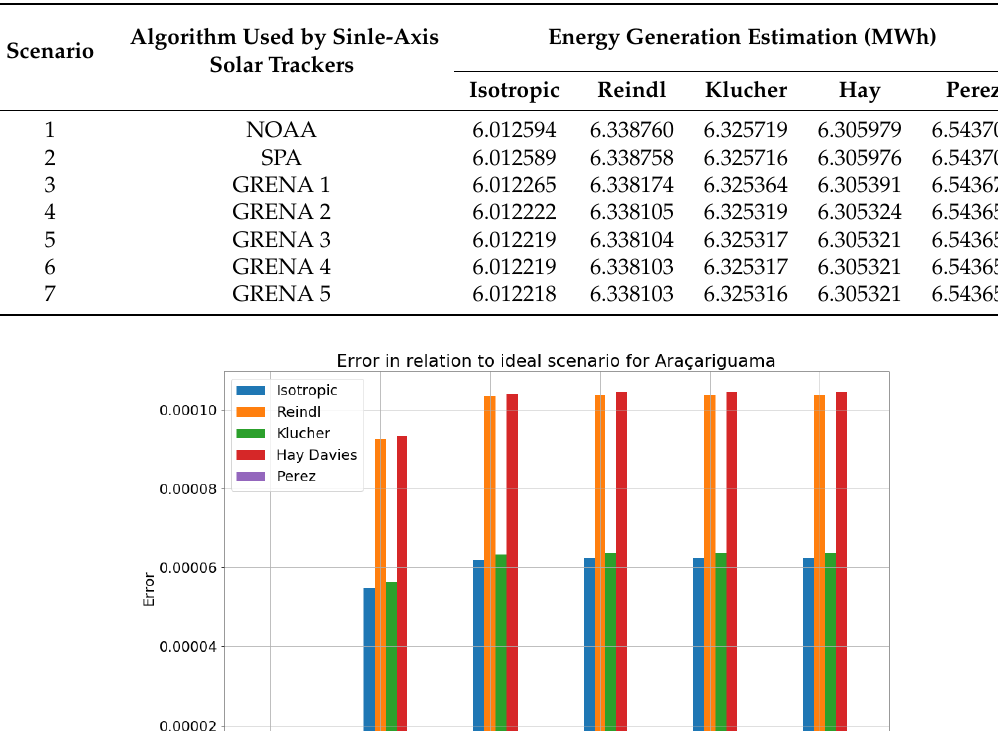
Table 3. Result of energy generation estimation using different algorithms for Sun tracking in Araçariguama, Brazil.